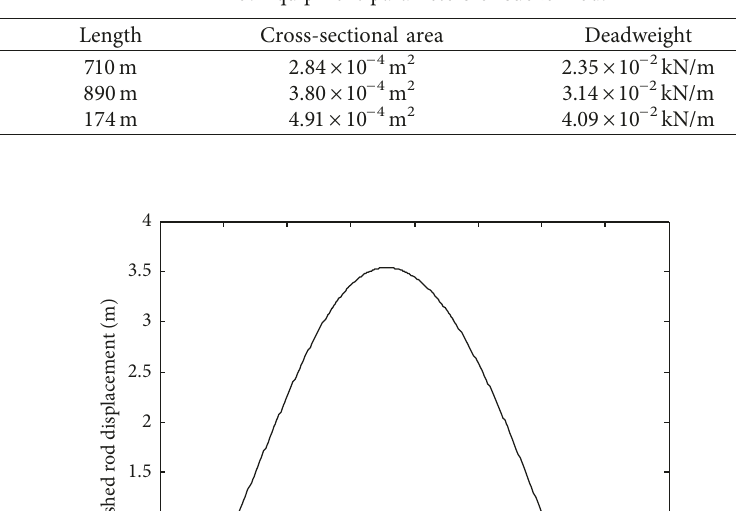
Table 3: Equipment parameters of sucker rod.